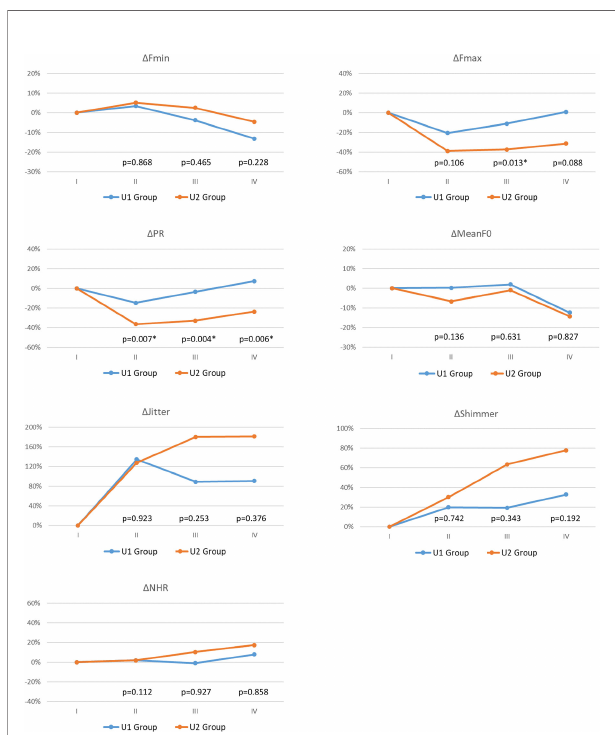
FIGURE 3 | Objective voice parameter changes ( D ) with different subjective voice outcomes during long-term postoperative period (Period-IV): U1 Group (Blue line, D IVST-T< 4 during Period-IV) and U2 Group (Red line, D IVST-T ≥ 4 during Period-IV). The abbreviations of objective/subjective voice parameters, the de fi nition of follow-up periods (I/II/III/IV), and the equation for calculating postoperative change in objective voice analysis are same in Figure 2 . The preoperative D is 0 in all the voice parameter. p value <0.05, showed signi fi cant